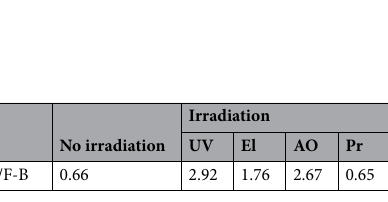
Table 3. F – /F-B ratios of